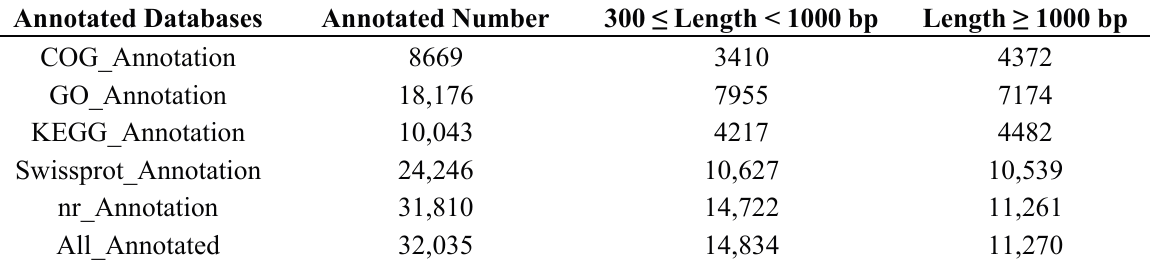
Table 1. Functional annotation of the C. medinalis transcriptome.